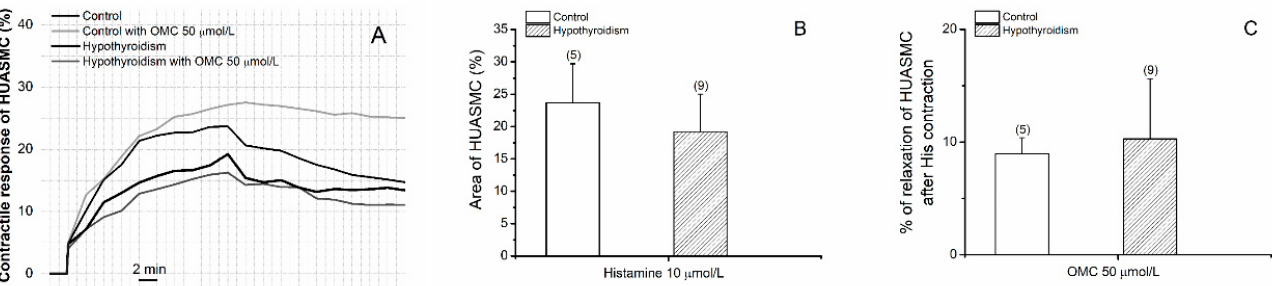
Figure 7. Effects of OMC on the human umbilical artery smooth muscle cells (HUASMCs) without (control) and with hypothyroidism incubated with octylmethoxycinnamate (OMC, 0 and 50 µmol/L) and contracted by histamine (His; 10 µmol/L). ( A ) Contractile response of HUASMC (%) during 40 min; ( B ) area (%) (at time 20 min) of the HUASMC and ( C ) percentage of relaxation of HUASMC after His contraction. Each bar represents the mean, vertical lines the S.E.M. and the number within brackets the n .